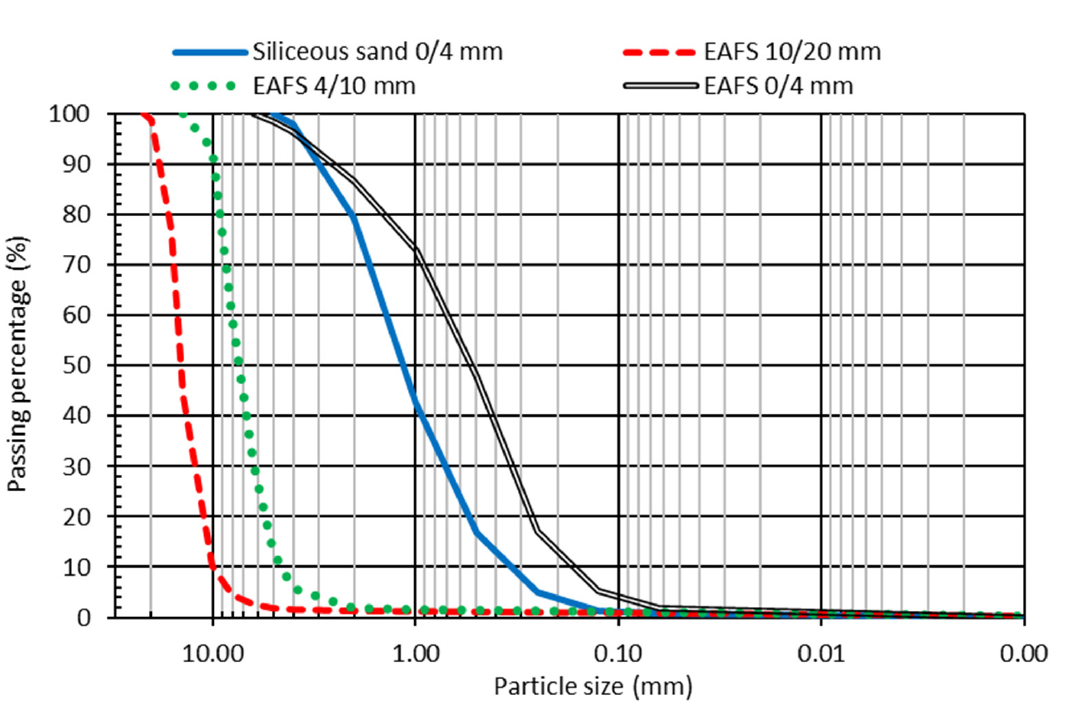
Figure 1. Gradation of aggregates.